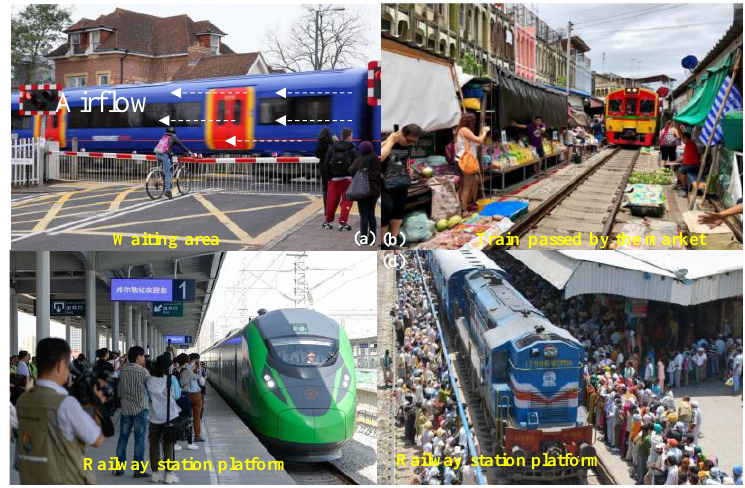
Figure 6. People waiting for a train running past ( a ) a crossing in the city; (b) market; (c) station and (d) platform.